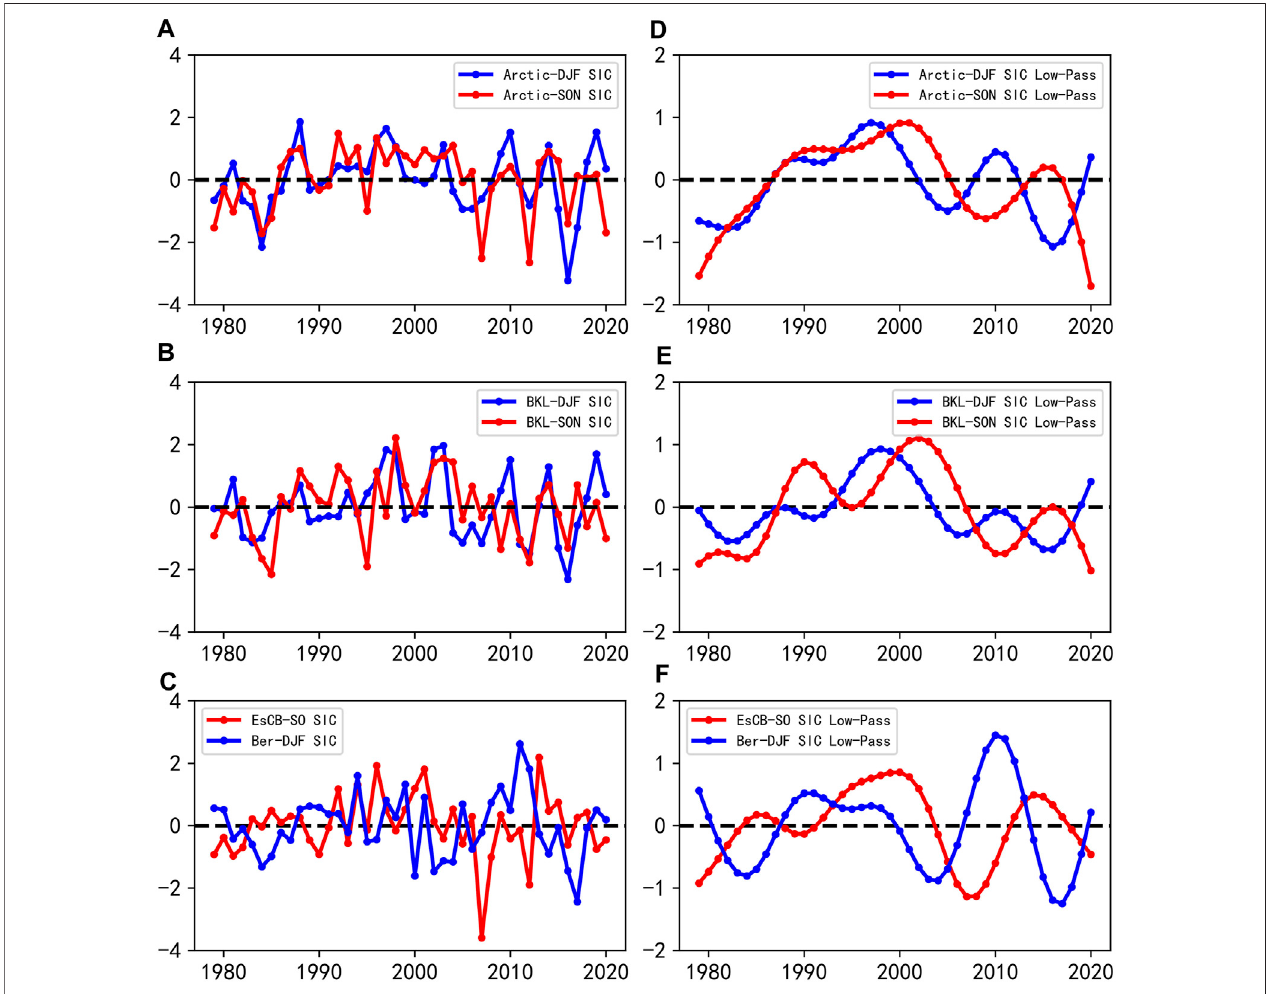
FIGURE 1 | Arctic sea-ice concentration (SIC) indices in different regions and seasons: (A) Pan-Arctic, (B) BKL in autumn (September – November) and winter (December – February), (C) EsCB in autumn (September – October) and Ber in winter. (D – F) As in (A – C) but for the corresponding 9-year low-pass fi ltered components. The blue (red) line denotes the winter (autumn) SIC index.